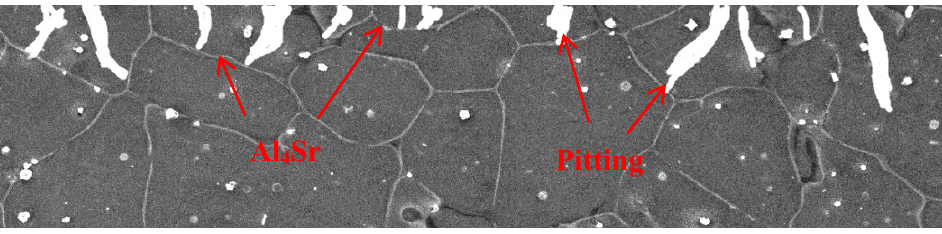
Figure 11. The schematic illustration of corrosion attack processes in Mg-9Li-3Al-2Sr-2Y alloy.